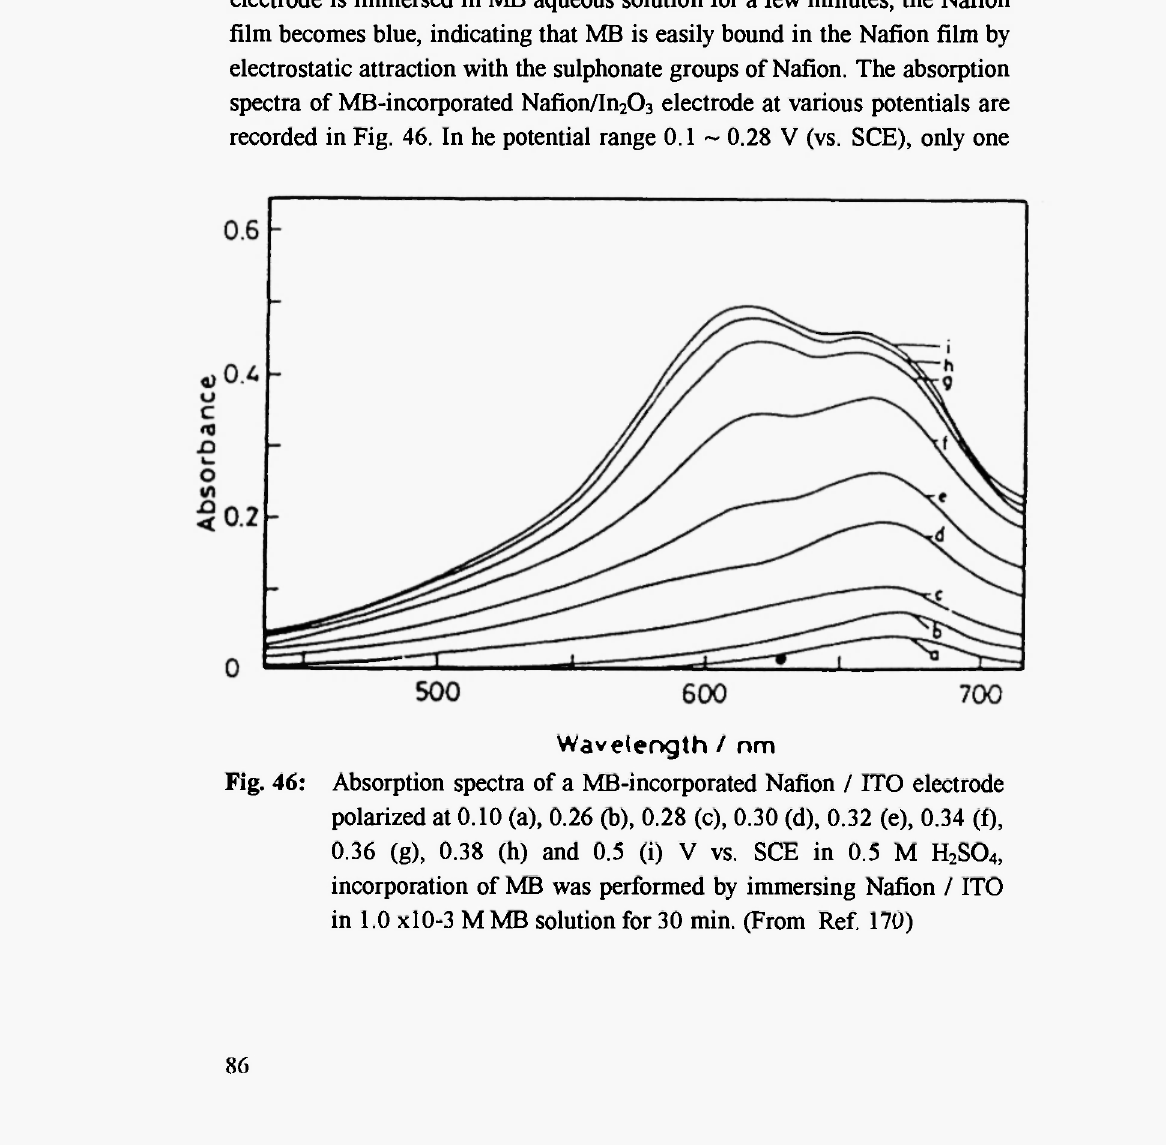
Fig. 46: Absorption spectra of a MB-incorporated Nafion / ΓΓΟ electrode polarized at 0.10 (a), 0.26 (b), 0.28 (c), 0.30 (d), 0.32 (e), 0.34 (f), 0.36 (g), 0.38 (h) and 0.5 (i) V vs. SCE in 0.5 Μ H incorporation of MB was performed by immersing Nafion / ITO in 1.0 xl0-3 Μ MB solution for 30 min. (From Ref.